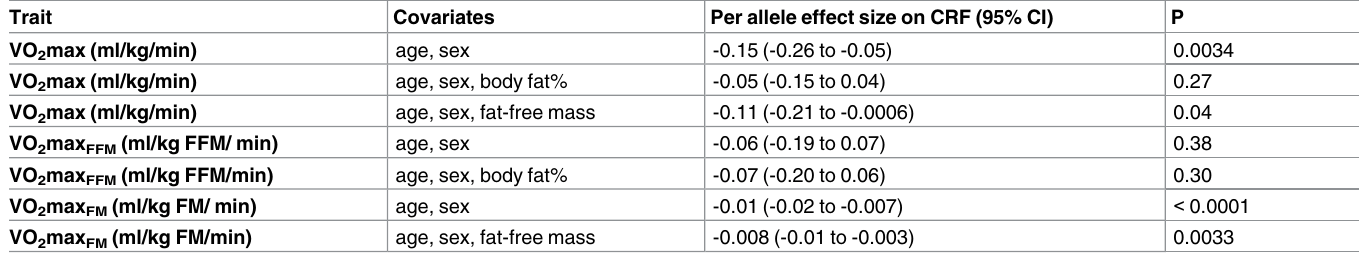
Table 2. Associations between body fat% GRS and CRF expressed in VO 2 max (ml/kg/min), VO 2 max FFM (ml/kg FFM/min) as well as VO 2 max FM (ml/ kg FM/min) after meta-analysis of two Danish cohorts (ADDITION-PRO (n = 716) and Health2006 (n = 2490)).